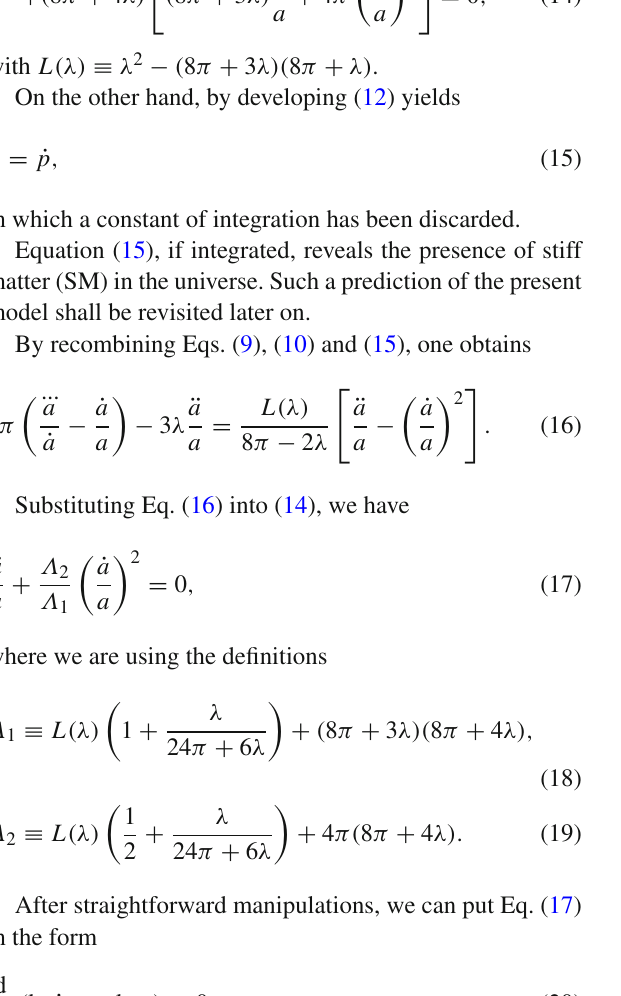
by using Eqs. (13) and (15), obtaining, in this way, solutions for the usual PF and for the SM fluid (SMF),